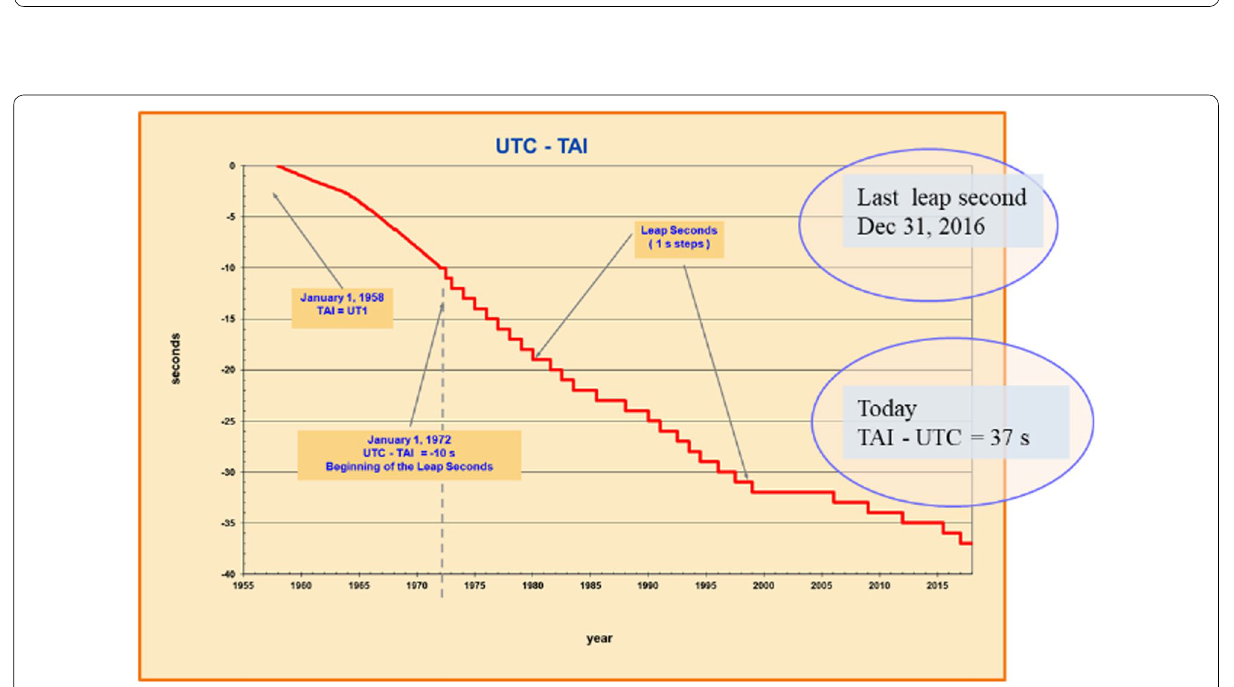
Fig. 8 The Universal Time Coordinated and its steps from TAI. The insertions of leap seconds started in